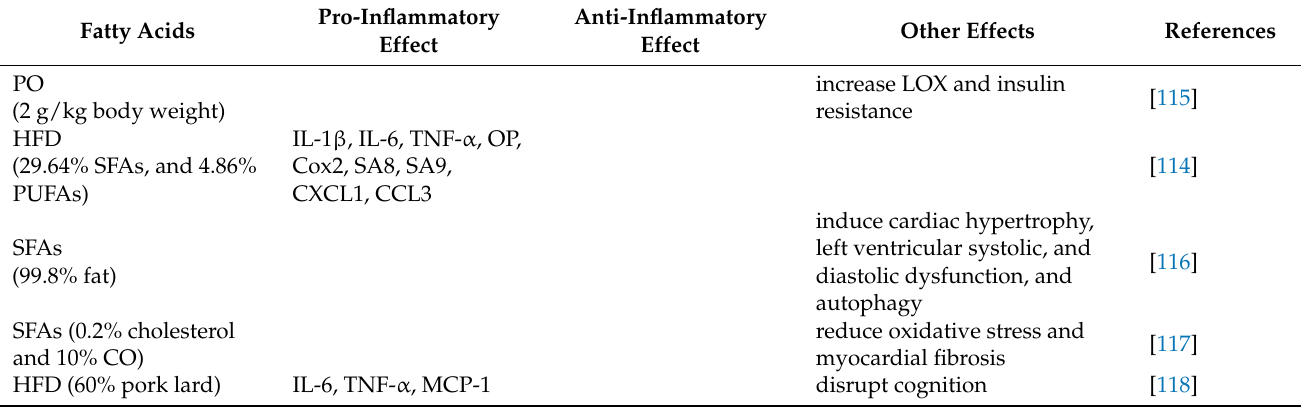
Table 2. Impact of dietary fatty acids on gene mediated inflammatory responses/outcomes: studies in animal models. Fatty